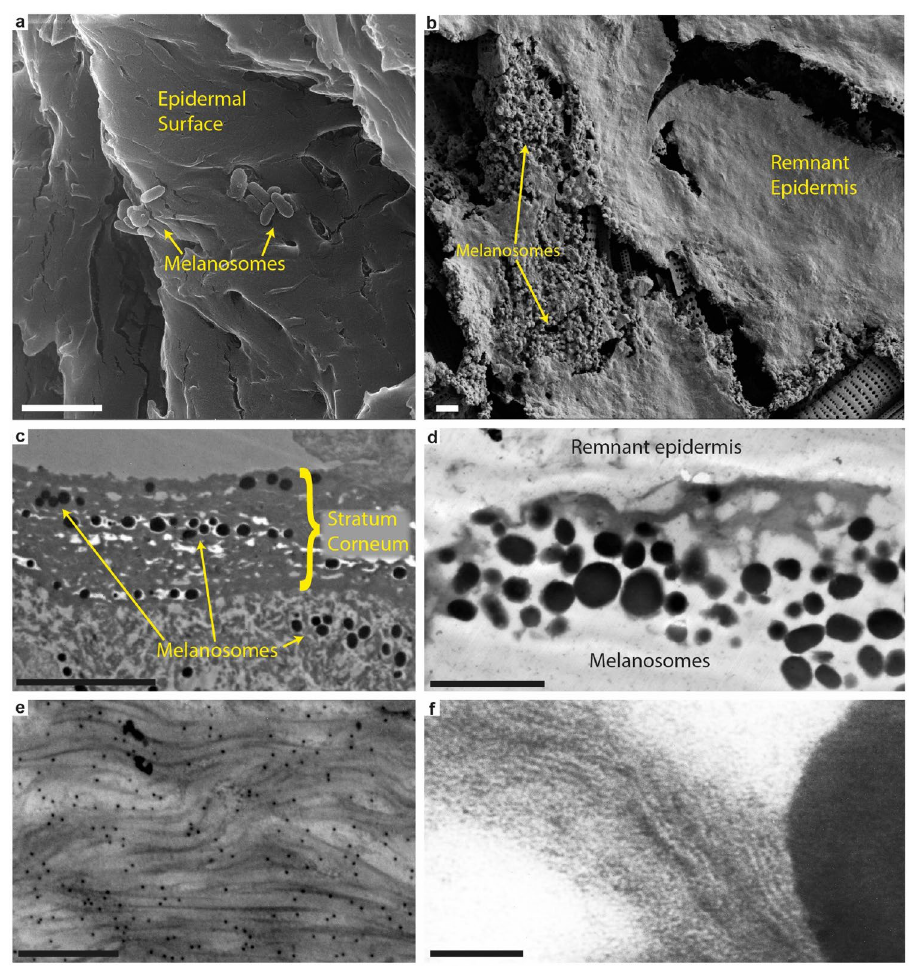
Figure 8. Side-by-side comparison of electron micrographs between modern sea turtle epidermis ( a , c , e ) and DK 807 flipper tissues ( b , d , f ). ( a ) SEM micrograph of the skin covering in a hatchling loggerhead sea turtle, Caretta caretta , showing melanosomes partially embedded in layered cornified proteins within the epidermis. ( b ) FEG-SEM micrograph of DK 807 flipper residue with swaths of sheet-like organic matter that partially covers remnant melanosomes. ( c ) TEM micrograph of carapace epidermis from a hatchling leatherback turtle, Dermochelys coriacea . ( d ) TEM micrograph of DK 807 flipper skin residue. ( e ) TEM micrograph of the carapace epidermis of a juvenile loggerhead sea turtle, Caretta caretta , with corneous protein filaments. ( f ) Close-up TEM micrograph of filamentous matter in the fossil flipper residue. Scale bars, 2 μm ( a , b , d ), 10 μm ( c ), 500 nm ( e ), 100 nm ( f